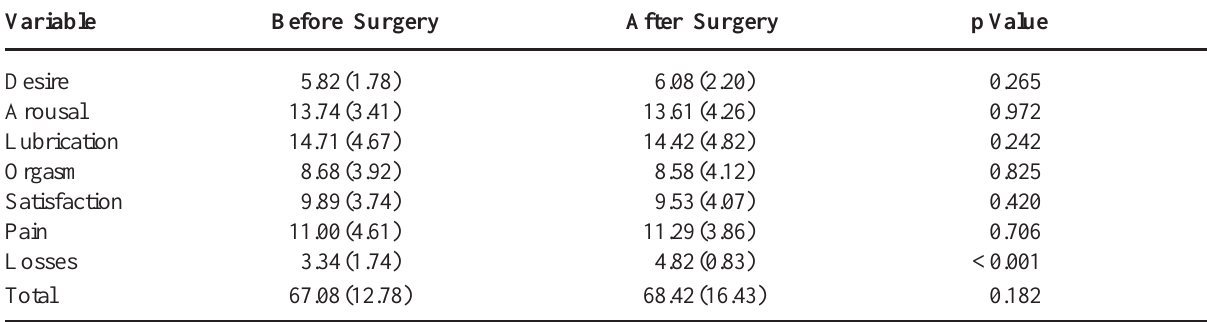
Table 5 – Comparison between mean scores before and after surgery, with significance level.